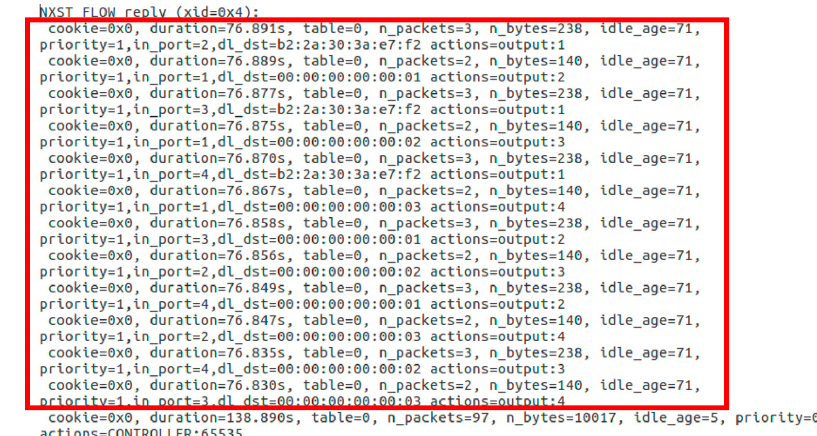
Figure 6. OpenFlow Switch Flow Rule Table Before a DDoS Attack.